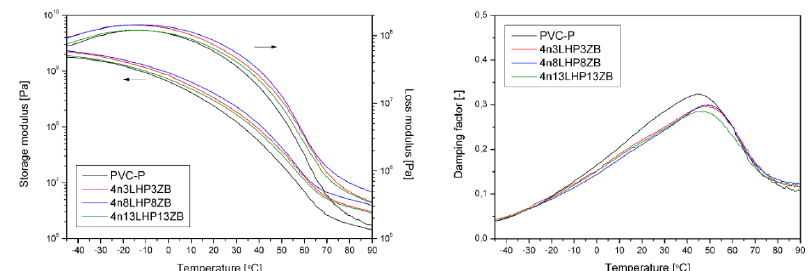
Figure 5. Storage and loss moduli and damping factors vs. temperature curves of pure and modified PVC-P. Table 2. Thermomechanical properties of pure and modified PVC-P.